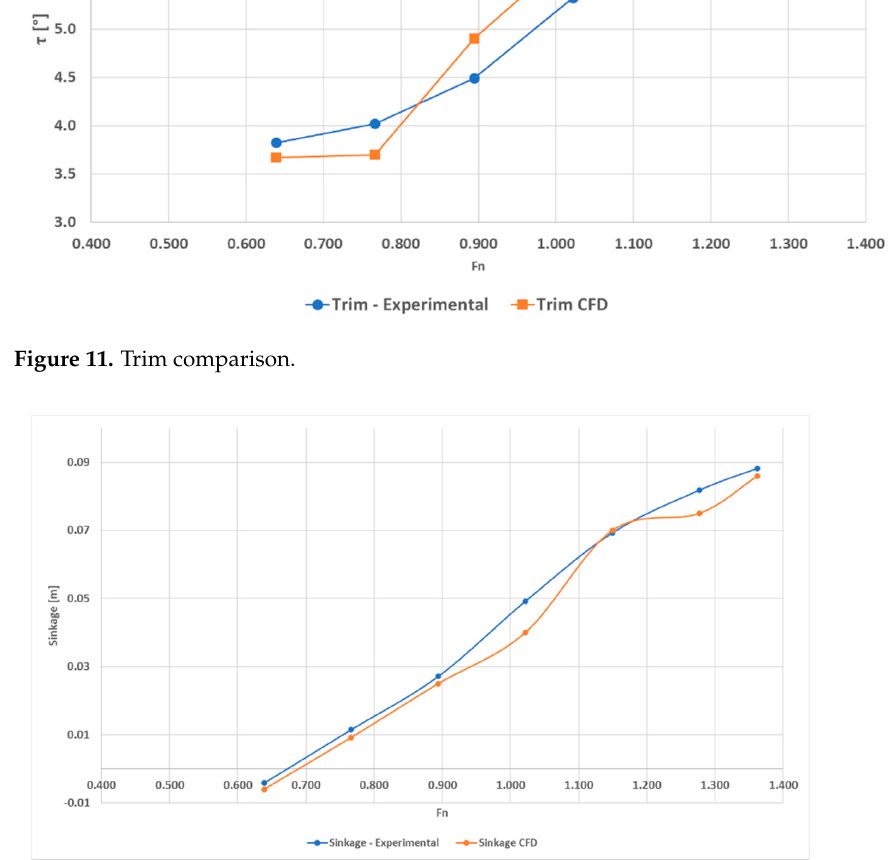
Figure 12. Sinkage comparison.